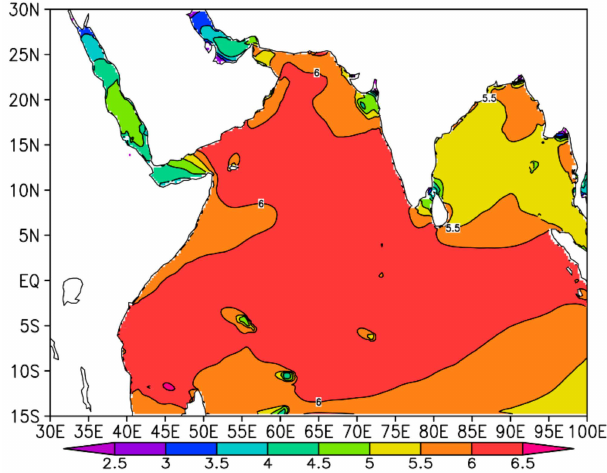
Figure 5. The distribution of 10-year average wave period (unit: